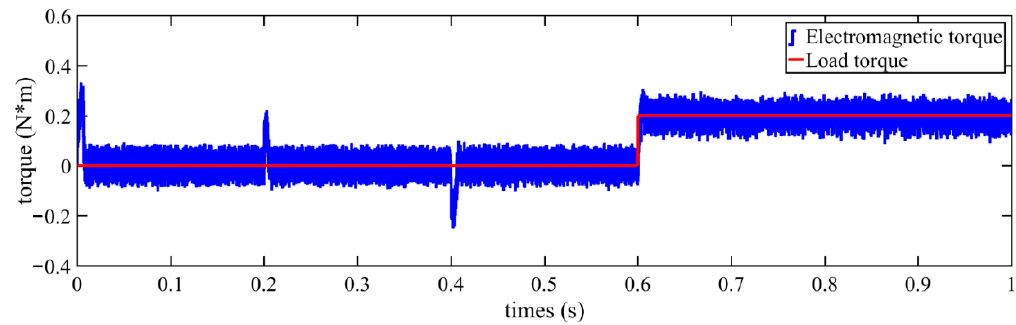
Figure 6. Torque waveform of two-stator HEPMSM.